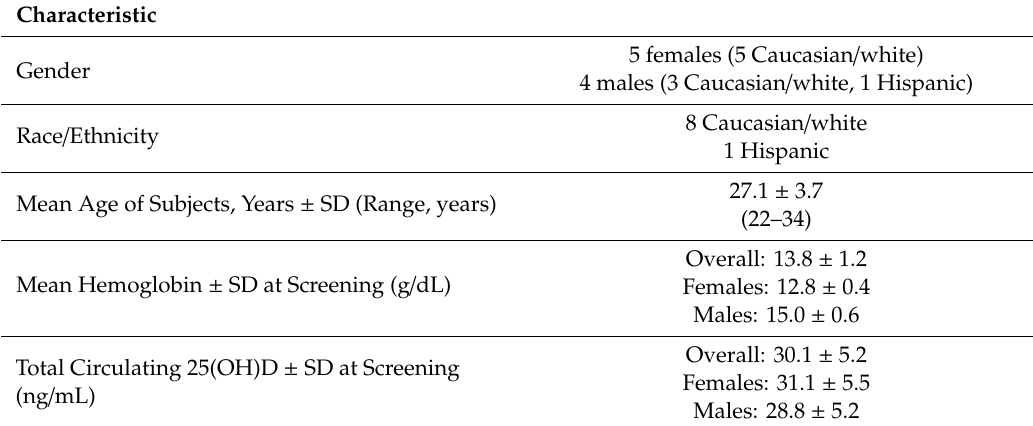
Table 2. Participant sociodemographic and clinical characteristics in Study 1 ( n = 9).